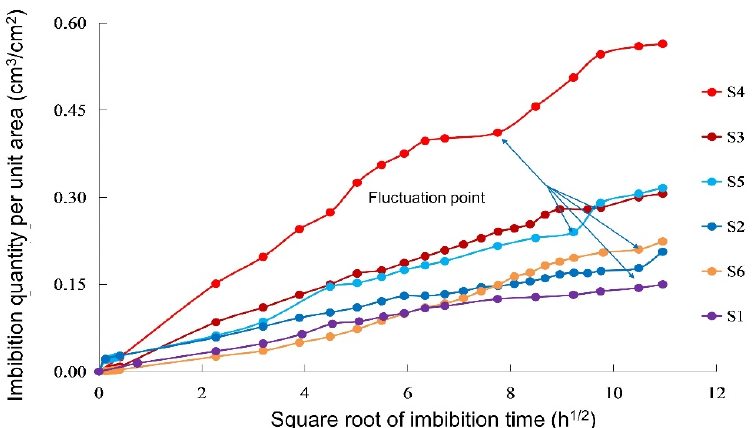
Figure 8. Relationship curves of imbibition quantity per unit area and square root of time of the 6